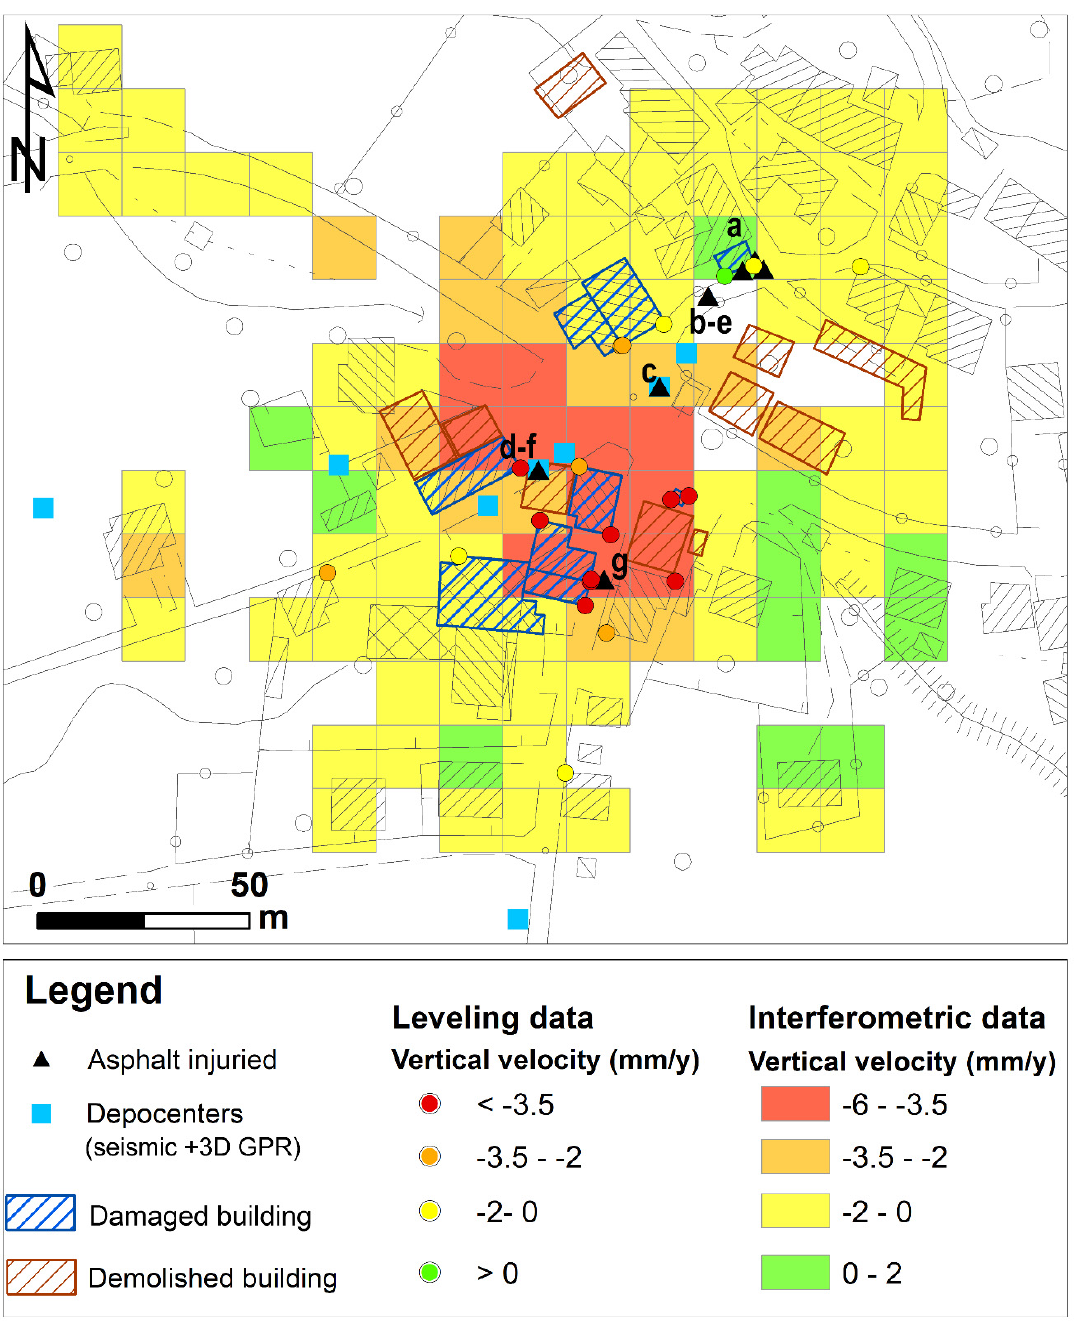
Figure 17. Synthetic map showing the combination of data obtained by the applied methodologies and highlighting the highest vulnerable zone. See text for details. Letters are related to damages presented in Figure 16.